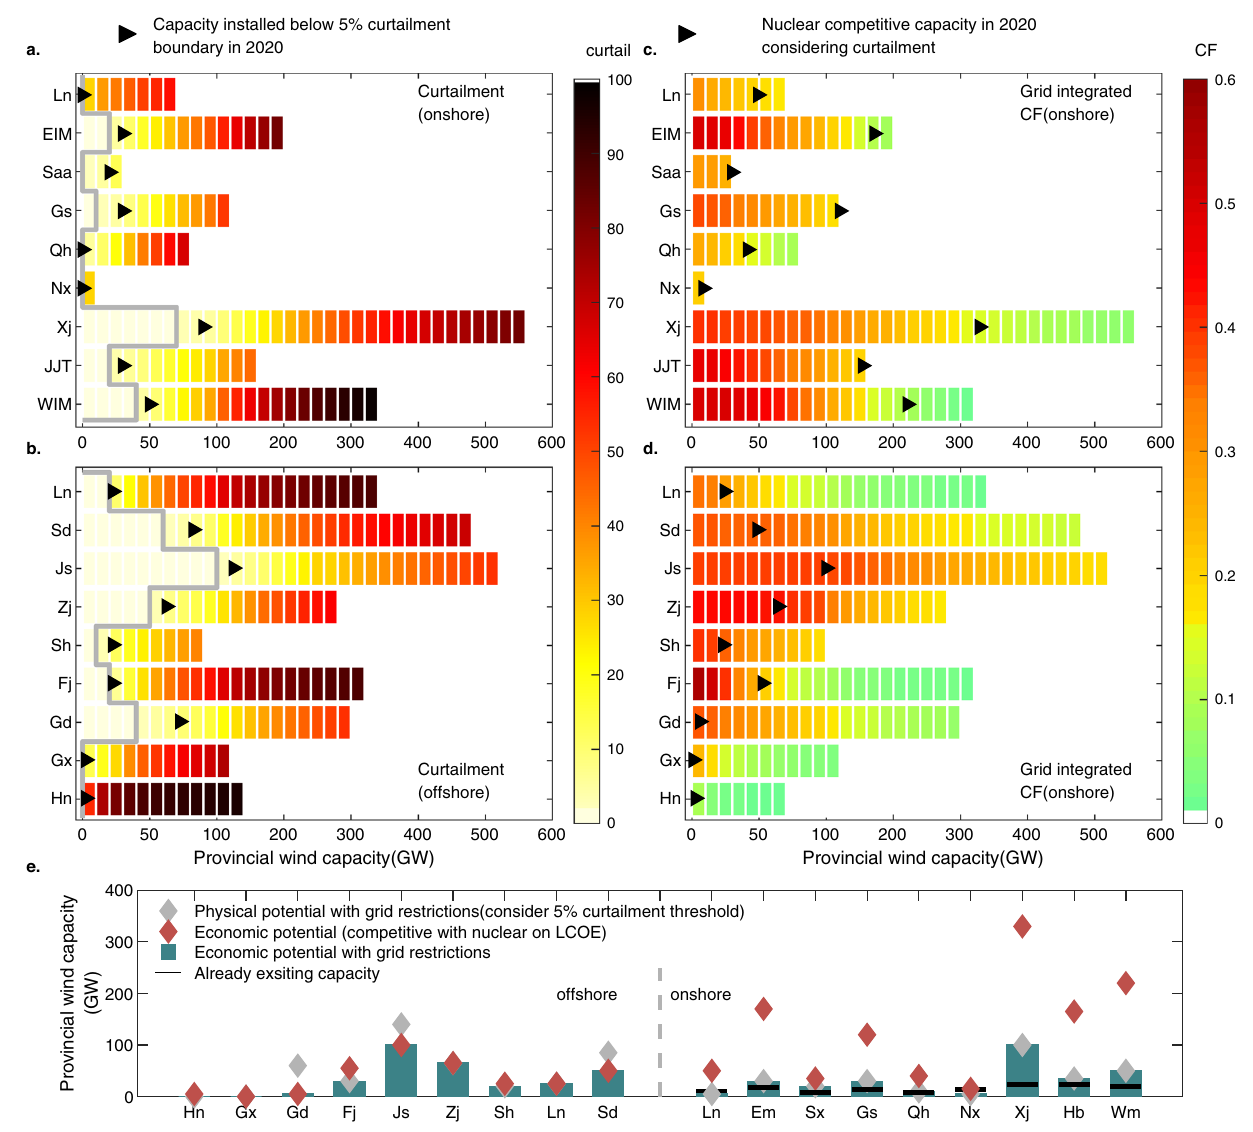
Fig. 3 | Annual curtailment rate and realized capacity factor for all the coastal provinces under various wind investment levels. a Annual onshore wind cur- tailment rate in 2020 grid structure. Limitation for the 5% curtailment rate pro- posed by NDRC is presented with black triangles. b Annual offshore wind curtailment rate in 2020 grid structure. Limitation for the 5% curtailment rate proposed by NDRC is presented with black triangles. c Realized capacity factor of onshore wind power considering possible curtailment losses in the integration simulations.Capacitycost-competitivewithnuclearpoweronLCOEbasisin2020is